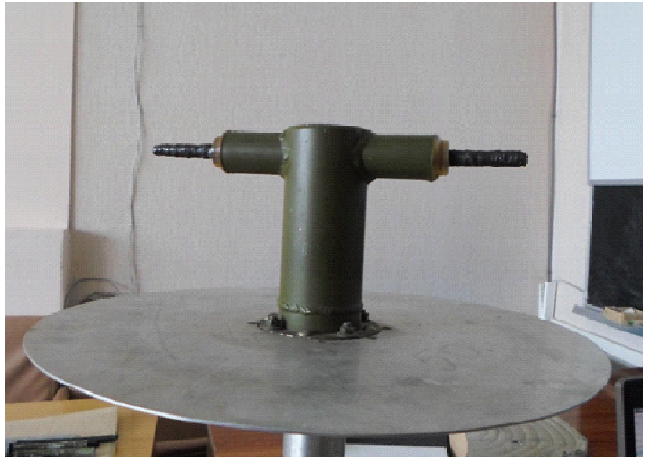
Figure 1. View of the dipole antenna operating at 600 MHz with its radiation elements made from carbon fiber.